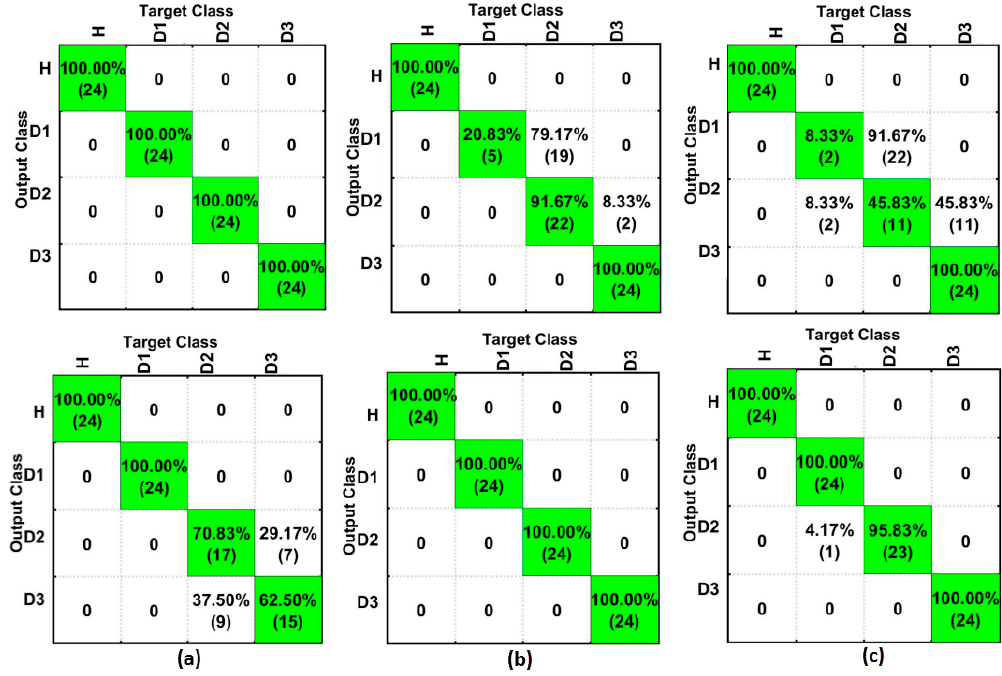
Figure 13. Comparison among the best obtained results for SFAN in the frequency domain (top), and SFAN in the time domain (bottom), for: ( a ) PZT#1; ( b ) PZT#2; and, ( c ) PZT#3.